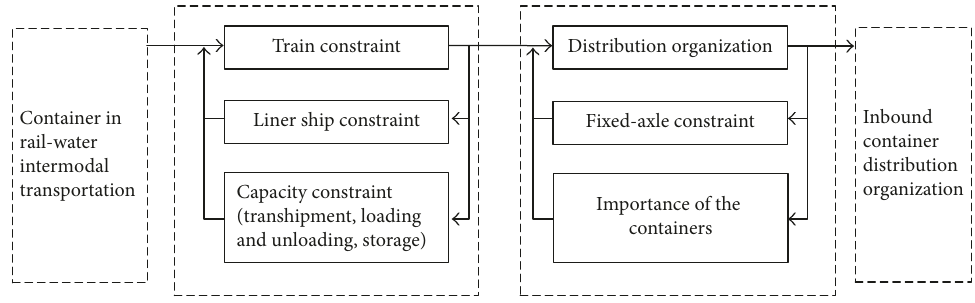
Figure 4: The simulation structure of inbound container distribution organization problem.